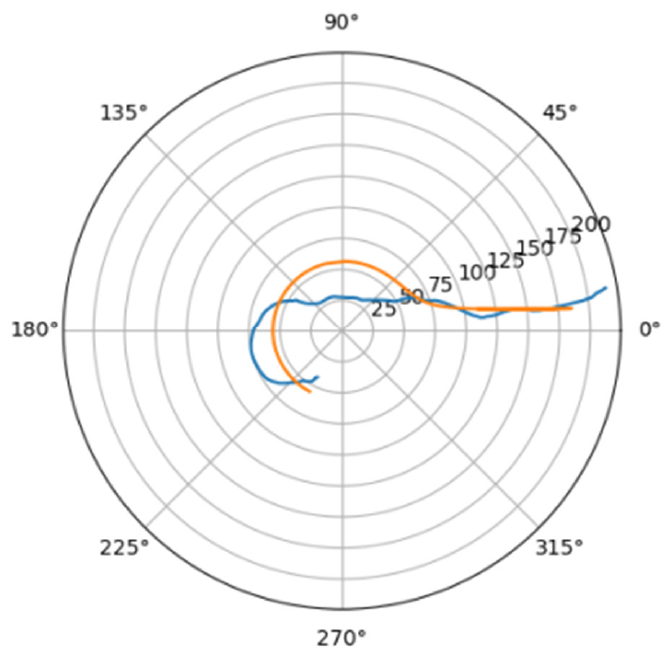
Figure 12. Approximations for bor_a.